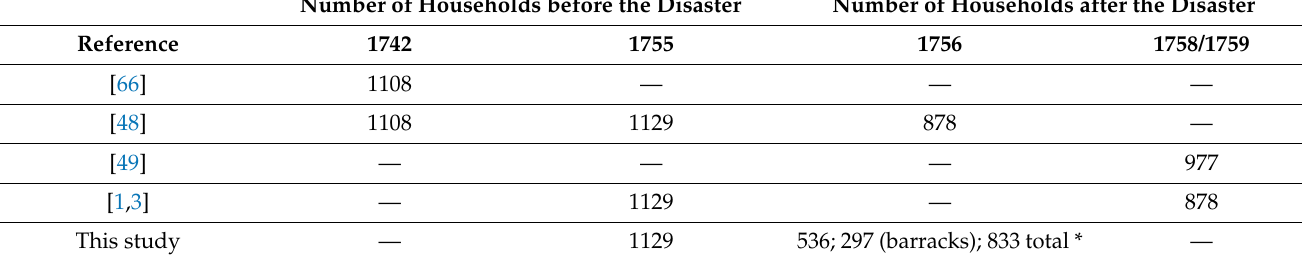
Table 1. Number of households before and after the disaster at Santo Estev ã o civil parish, according to several authors. Several discrepancies have been found